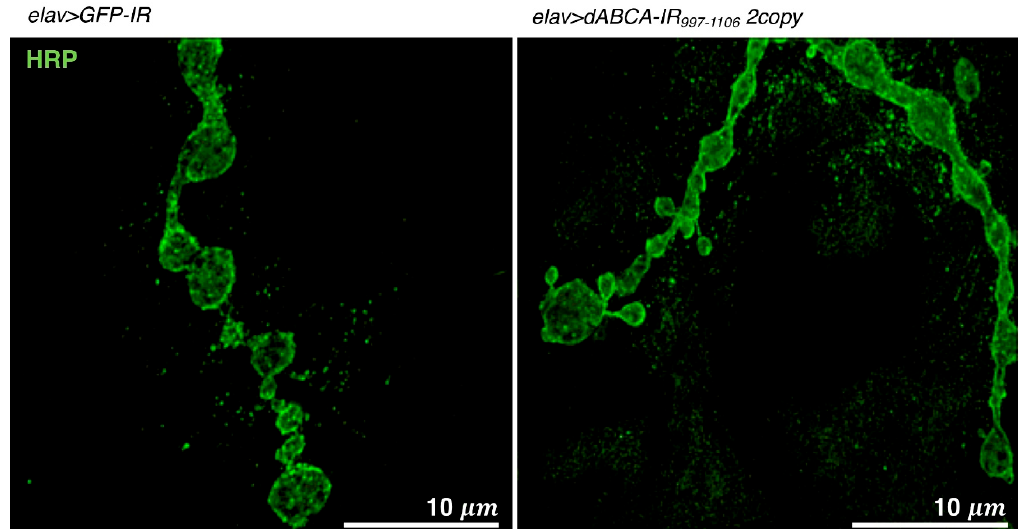
Figure 4. Visualization of NMJs in muscle 4 of a third instar larva. Images show NMJs that were stained with anti-HRP IgG. Images were taken using a super-resolution microscope (N-SIM, Nikon). elav>GFP-IR , w/Y; UAS-GFP-IR/+; elav-Gal4/+. elav>dABCA-IR 997-1106 2copy , w/Y; UAS-dABCA-IR 997-1106 /UAS-dABCA-IR 997-1106 ; elav-Gal4/+. Bars indicate 10 μ m.